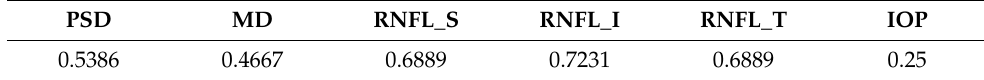
Table 9. Results of reversing four normalized feature